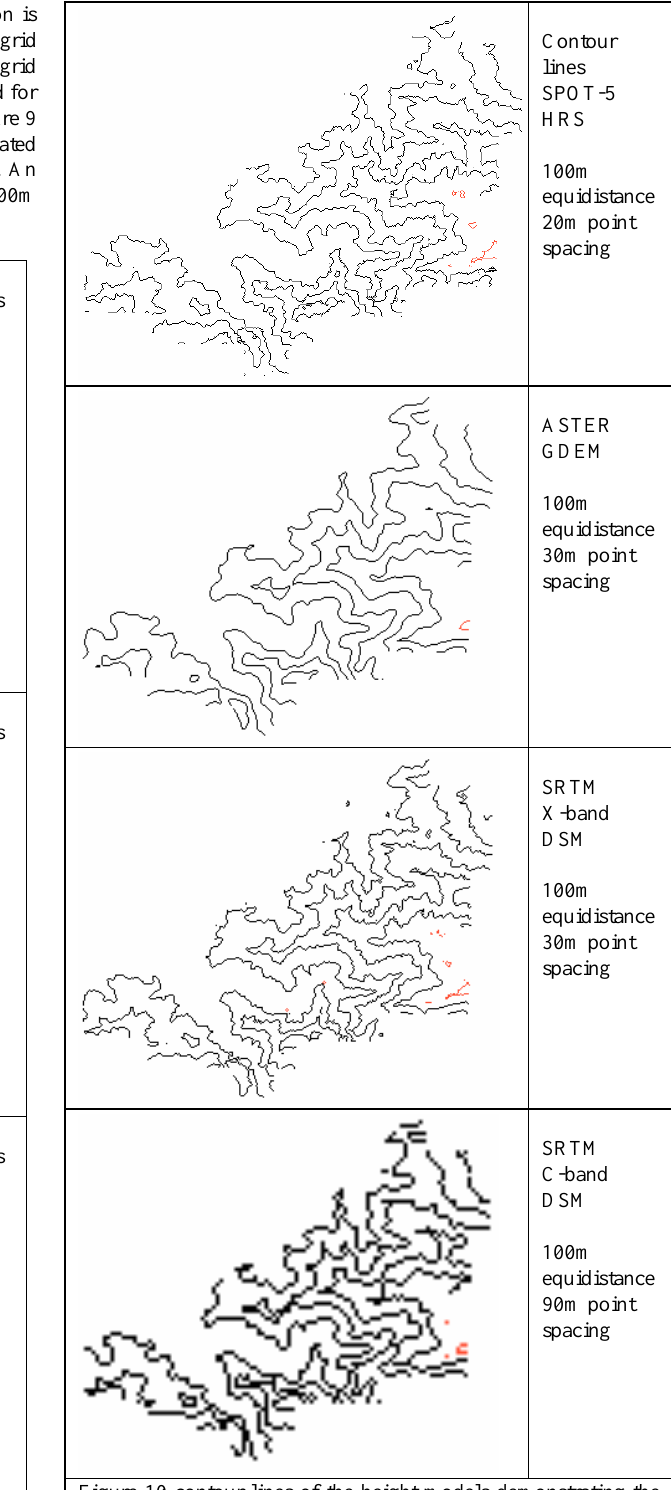
Figure 10 contour lines of the height models demonstrating the morphologic quality (Zonguldak) As it can be seen from above figures, the structure of contour lines generated from SPOT-5 HRS is more detailed. The comparison of ASTER GDEM and SRTM X-band DSM is very interesting because the SRTM X-band contour lines are more detailed than ASTER contour lines even if they have similar grid spacing. ASTER GDEM contour lines are smoother.